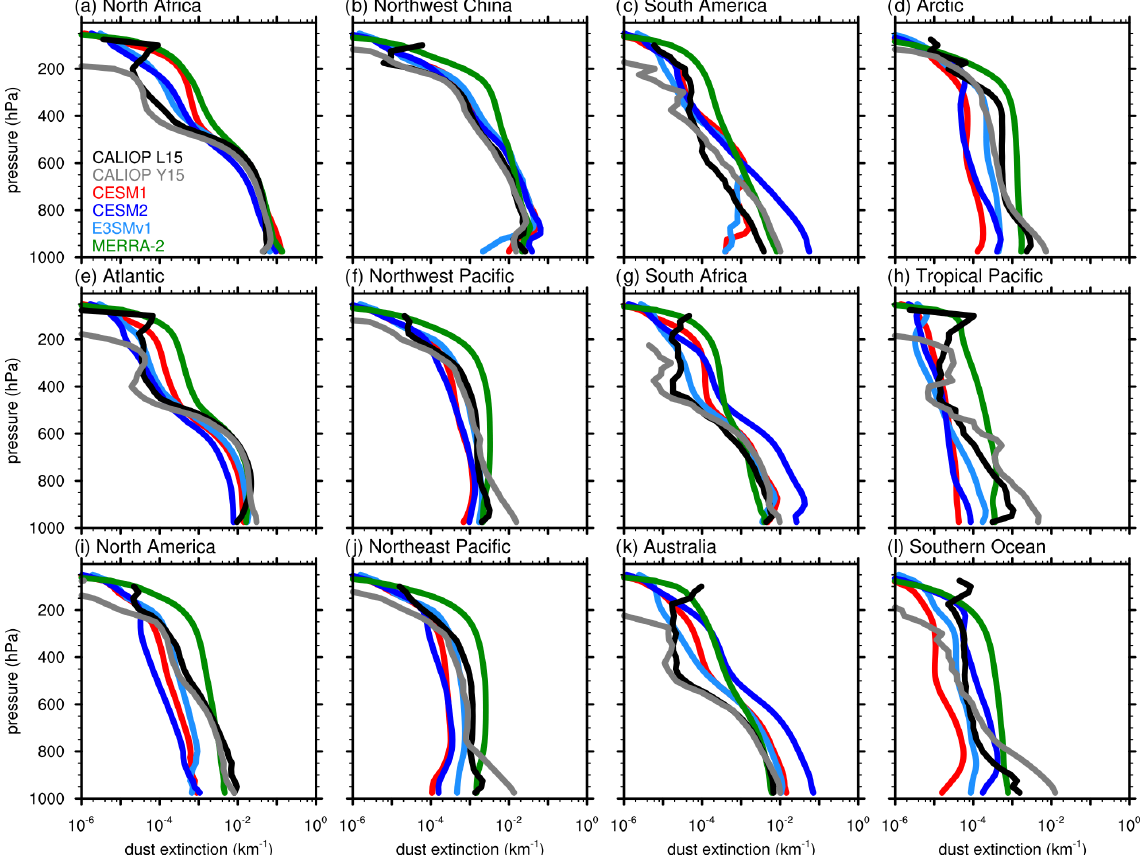
Figure 8. Vertical profiles of annual mean dust extinction (km − 1 ) from model simulations and CALIOP over 12 selected regions during